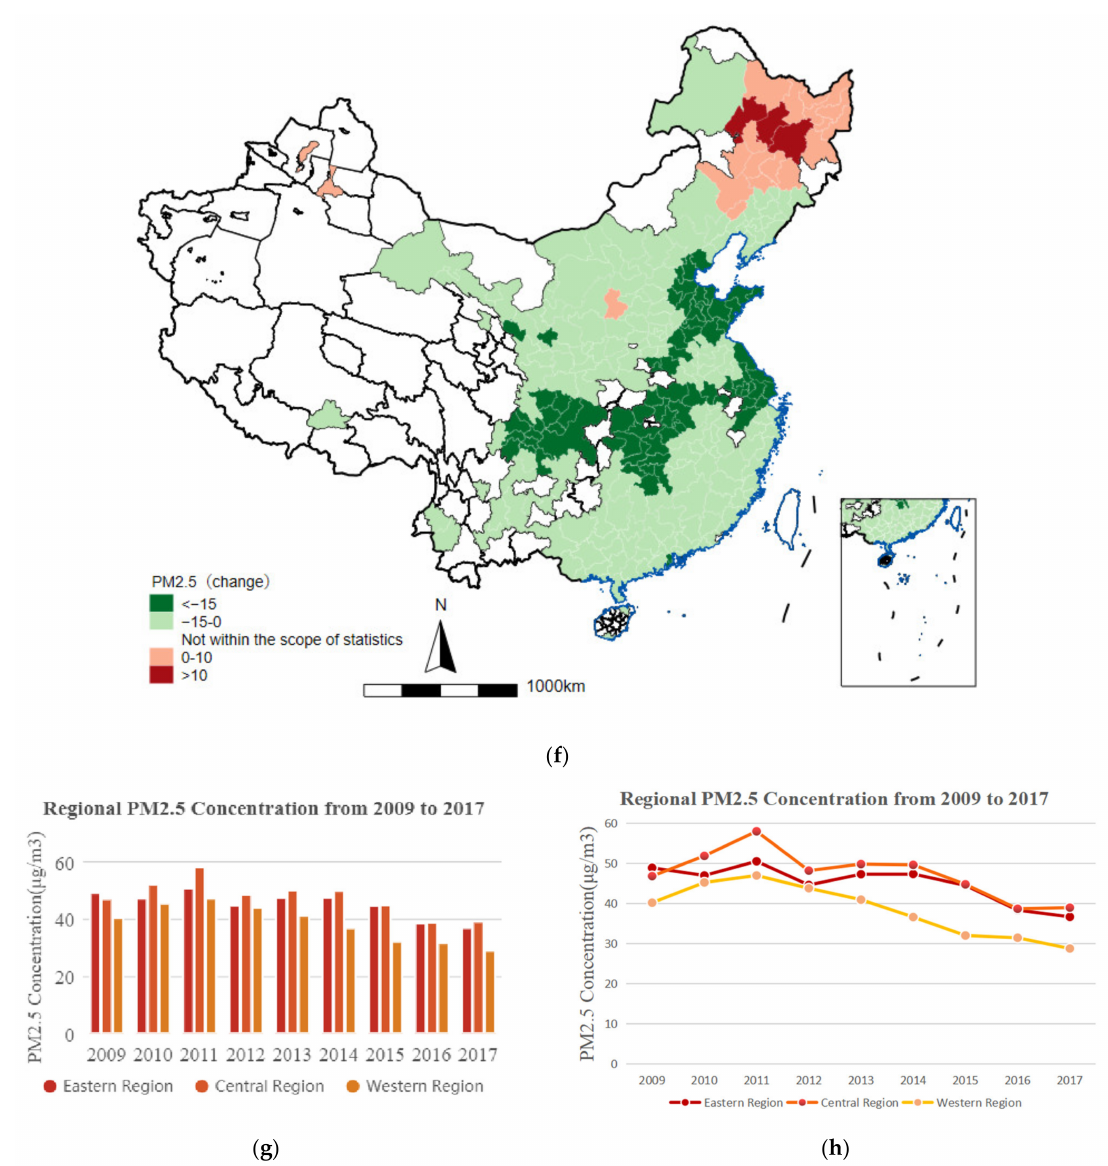
Figure 4. ( a – e ) PM2.5 in 2009, 2011, 2013, 2015, and 2017; ( f ) PM2.5 change from 2009 to year 2017; ( g , h ) regional PM2.5 concentration from 2009 to